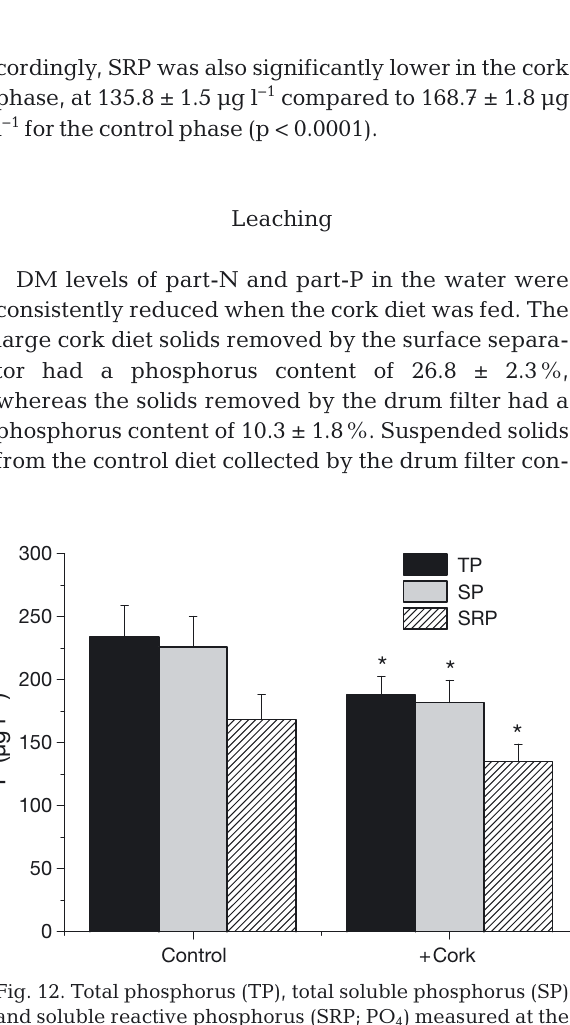
Fig. 11. Nitrite levels and single pass removal efficiencies during the control diet and cork diet phases of the trial. Bars marked with asterisks differ significantly from the control Fig. 10. Timeline of nitrite levels during the trials, measured (p < 0.0001). Values are means ± SE before and after the biofilter for both diets (n = 80). Values are means ± SE